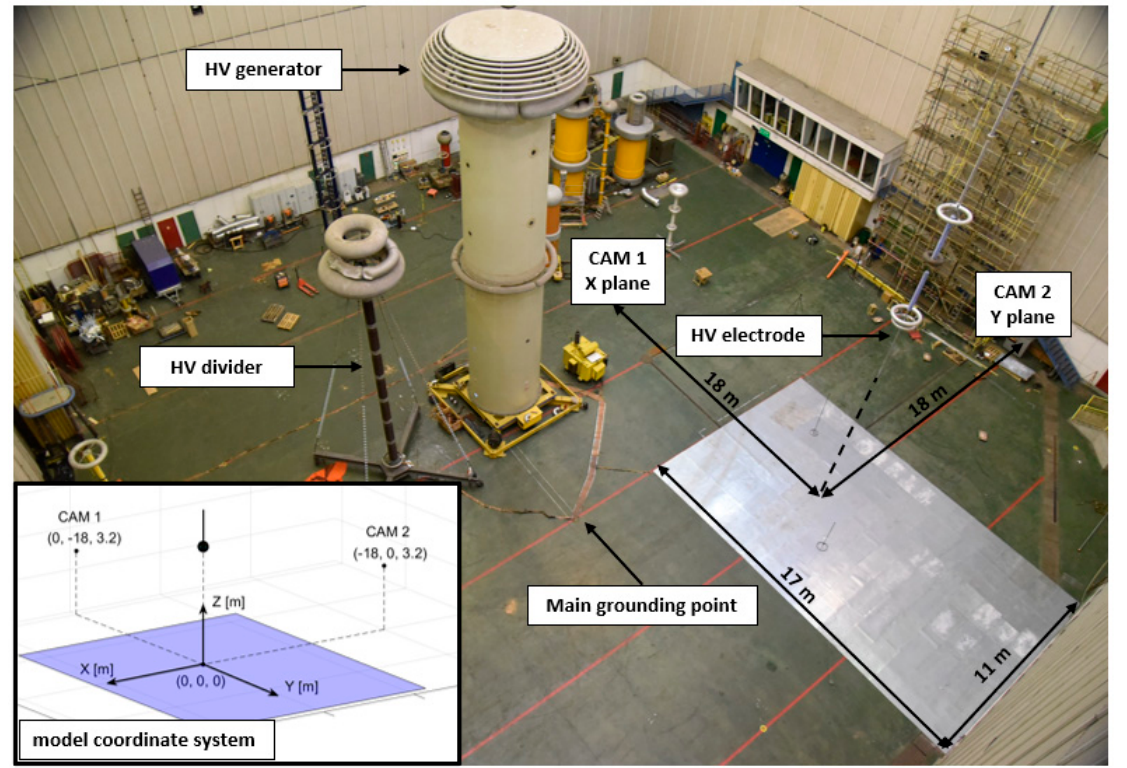
Figure 4. Test field with measuring system arranged at High Voltage Laboratory of Institute of Power Engineering in Warsaw, Poland, allowing that the distribution of the electric field in the tested spark gap was not distorted by the measuring equipment and the structural elements of the laboratory hall.